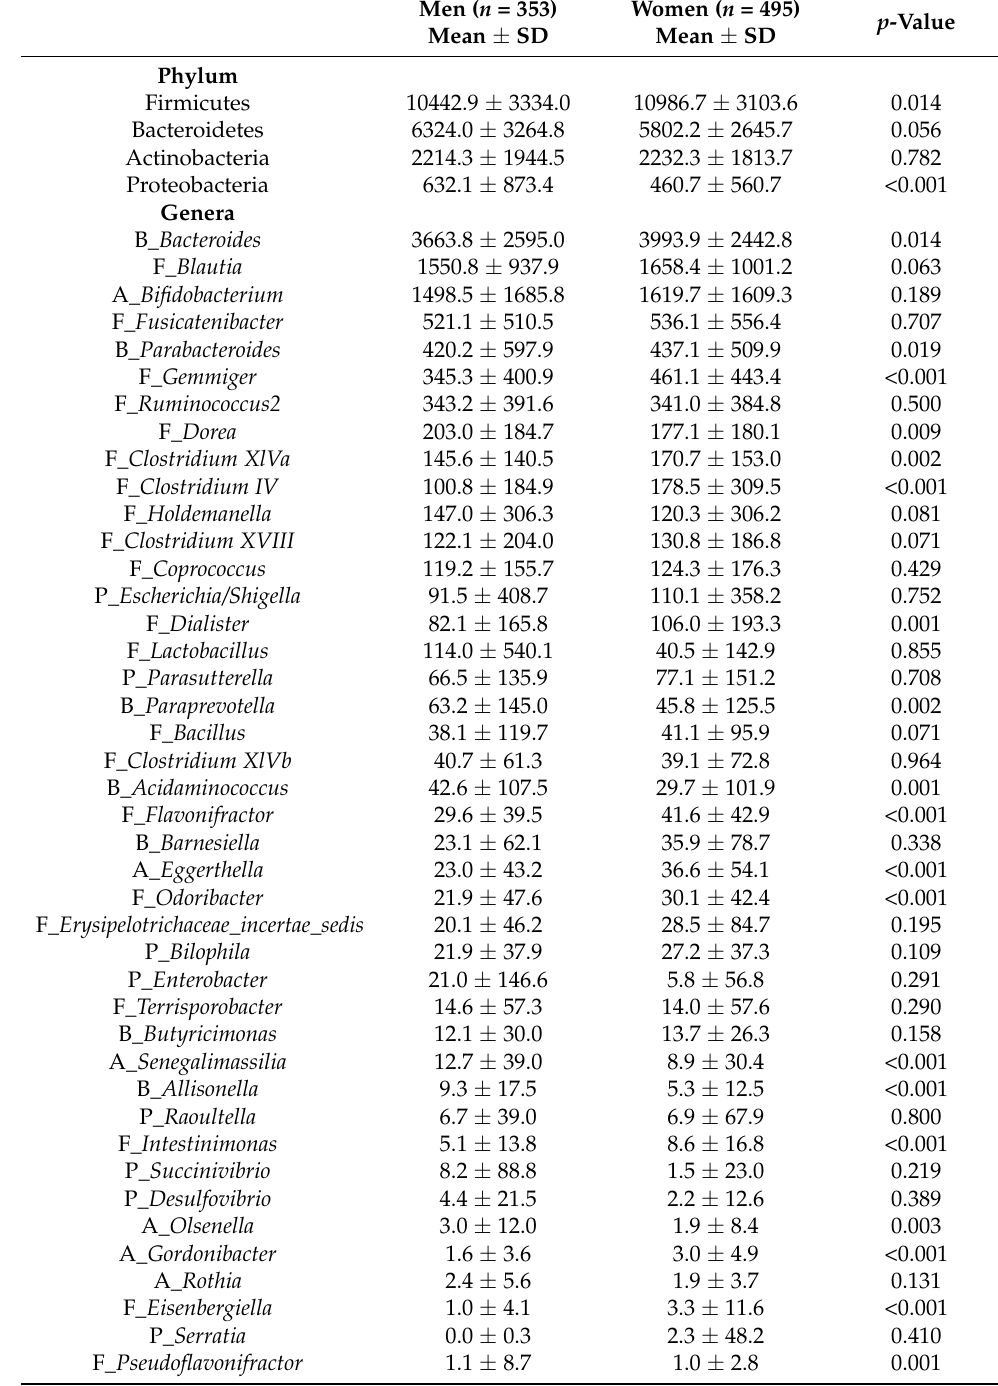
Table 2. Gut microbiota